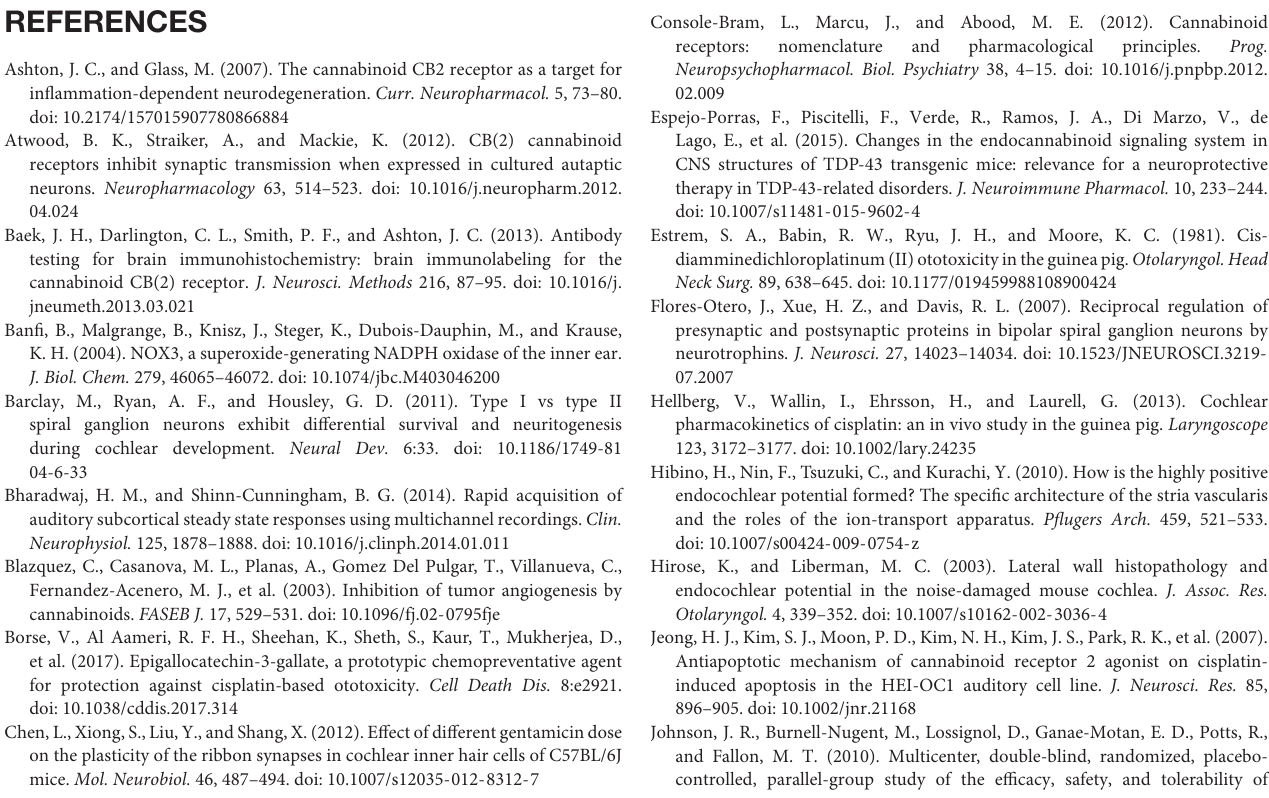
FIGURE S1 | Characterization of the CB2R. (A) Specificity of CB2R immunolabeling was confirmed in mid-modiolar sections using a blocking peptide for the CB2R protein which revealed an absence of labeled proteins. (B) UB/OC1 cells were transiently transfected with a plasmid vector expressing CB2R. Cells were fixed in 4% paraformaldehyde, washed with PBS and then immunolabeled for CB2R (green). Labeling in the untransfected cells was confined to the plasma membrane and was substantially increased following transient transfection of CB2R. FIGURE S2 | Administration of AM630 alone does not reduce OHC number and did not alter the effect of cisplatin. The animals were sacrificed at the end point and cochleae were collected, fixed by 4% PFA in PBS followed by decalcification in 100 mM EDTA for 3 weeks. The base of the cochlea were dissected out and stained with hair cell marker, myosin VIIa, to determine the hair cell loss. Representative images are shown. Scale bar is 20 µ m. TABLE S1 | Description of antibodies